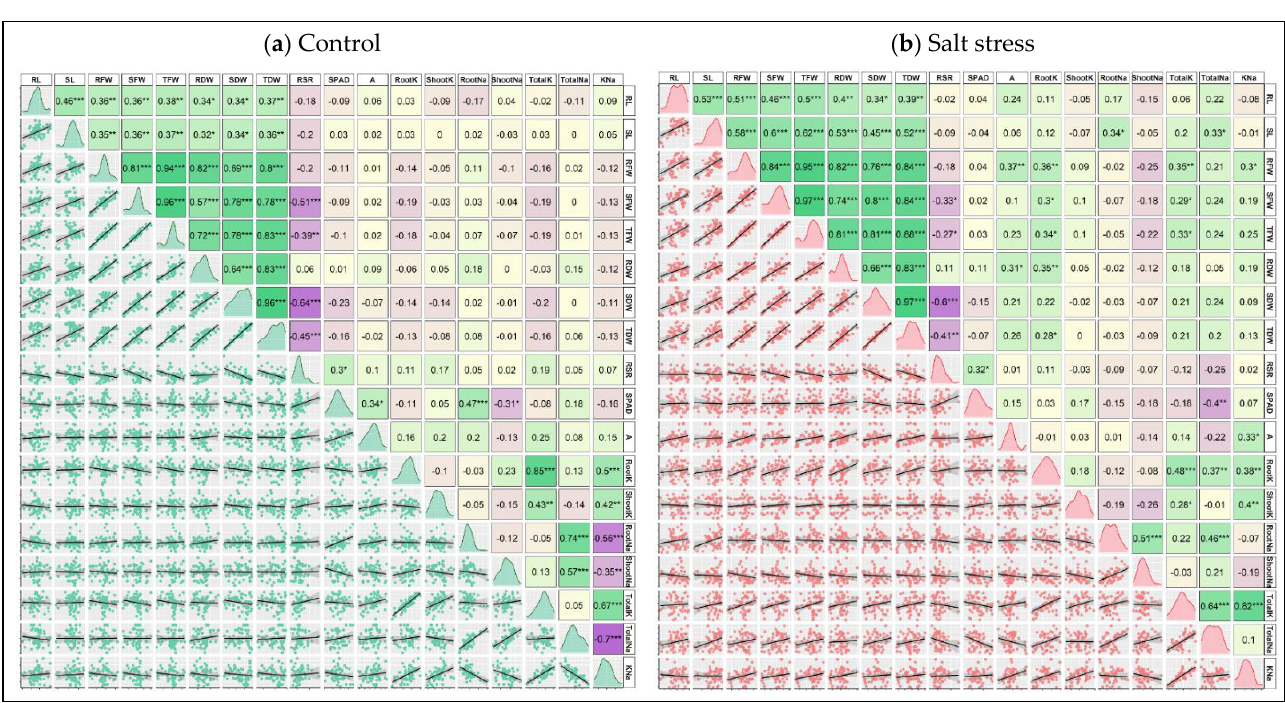
Figure 7. Scatter plot, data distribution and correlation matrix of the 18 examined seedling traits of 18 maize cultivars grown in control ( a ) and salt stress ( b ) conditions. In the upper panels of both figures, green, corn silk and purple boxes denote positive, neutral and negative correlations with correlation coefficient values of 1, 0 and − 1, respectively. The